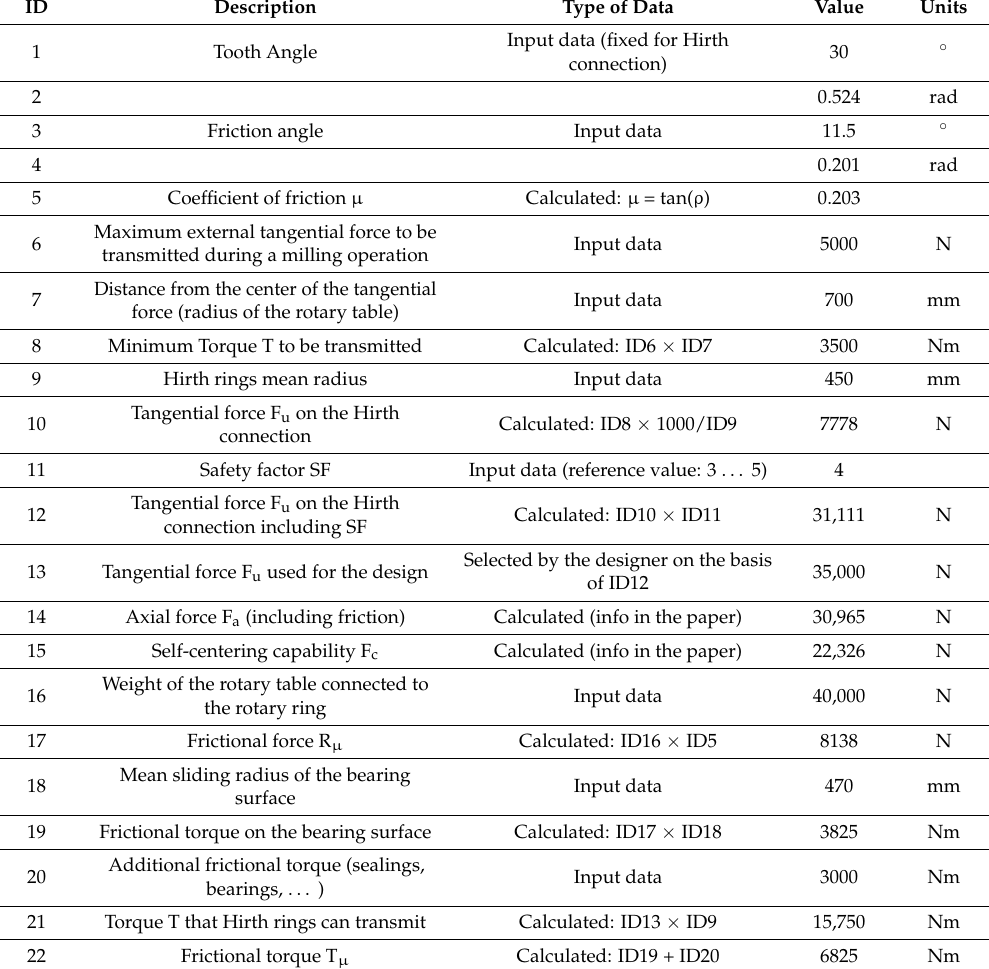
Figure 13. Comparison between the status of a new Hirth connection vs. a rusty one. The data for the calculation are reported in Table 5. Table 5. Calculation data for a rotary table of a transfer machine (Figure 7a).